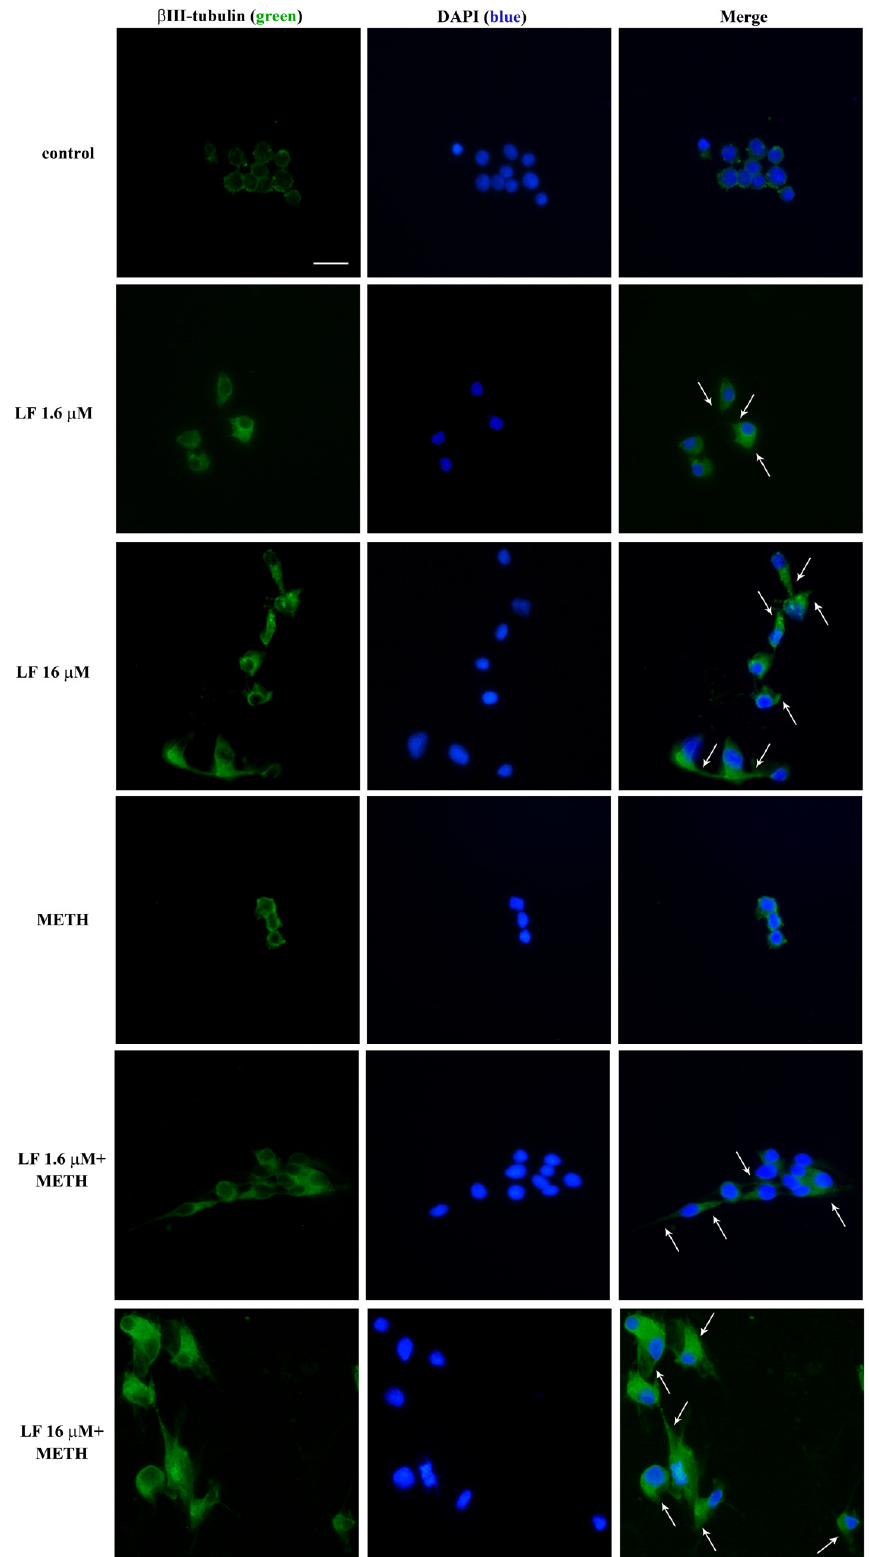
Figure 7. Representative β III-tubulin immuno-fluorescence. Representative pictures of β III-tubulin immuno-fluorescence after single and combined LF (1.6 µ M and 16 µ M) and METH administration. Arrows indicate β III-tubulin immuno-fluorescent cell branches. Scale bar = 16 µ